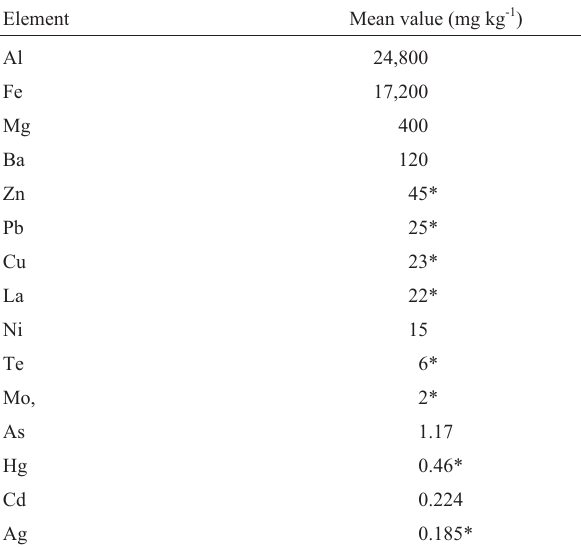
Table 5 - Analysis of Pitimbu river sediments. An asterisk indicates levels exceedingthosepermittedbytheBrazilianNationalEnvironmentCouncil (see heading to Table 2). The cytotoxic and/or genotoxic compounds present in the river water were not directly identified in this study but were assessed in the study by Santos et al. (2002), previously unpublished data from which is given in this